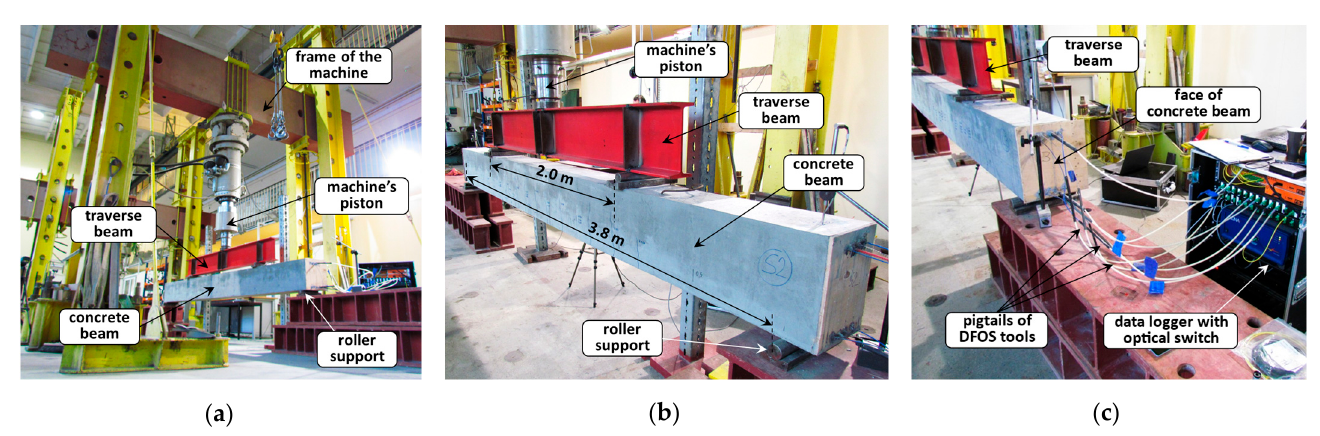
Figure 17. ( a ) The view of the measurement station; ( b ) close-up to the example beam; ( c ) Rayleigh-based data logger with an optical switch connected to embedded DFOS tools.